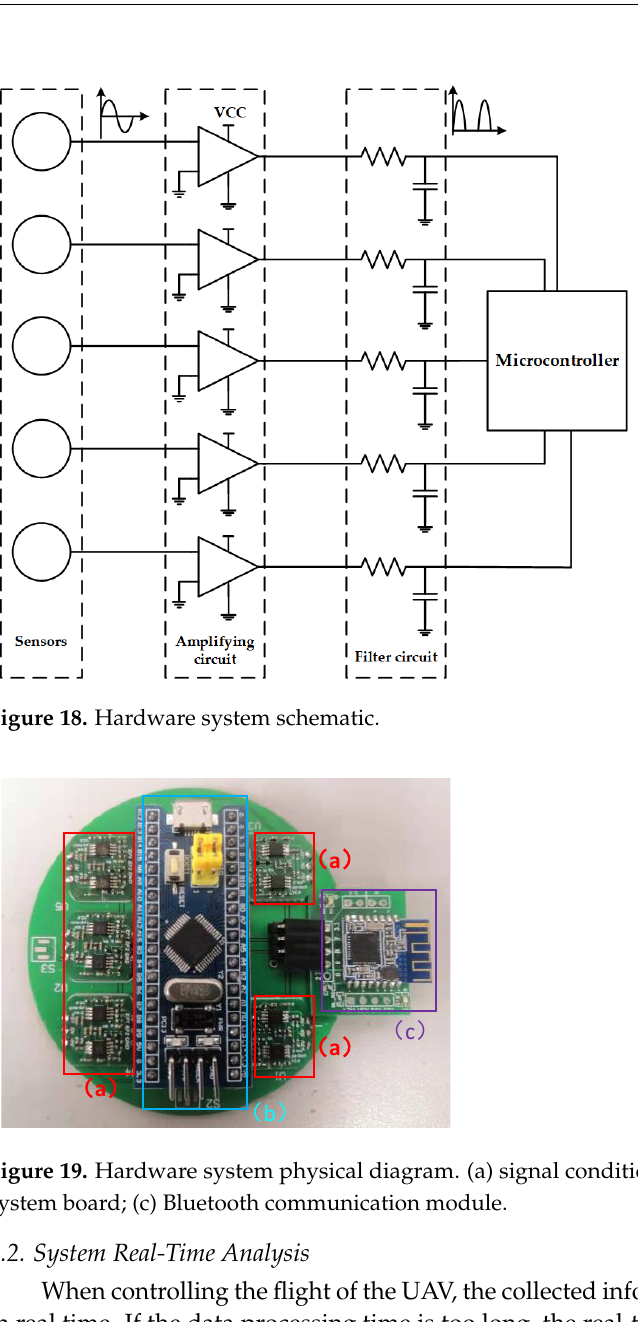
Figure 19. Hardware system physical diagram.(a) signal conditioning circuit;(b) STM32 minimal system board;(c) Bluetooth communication module